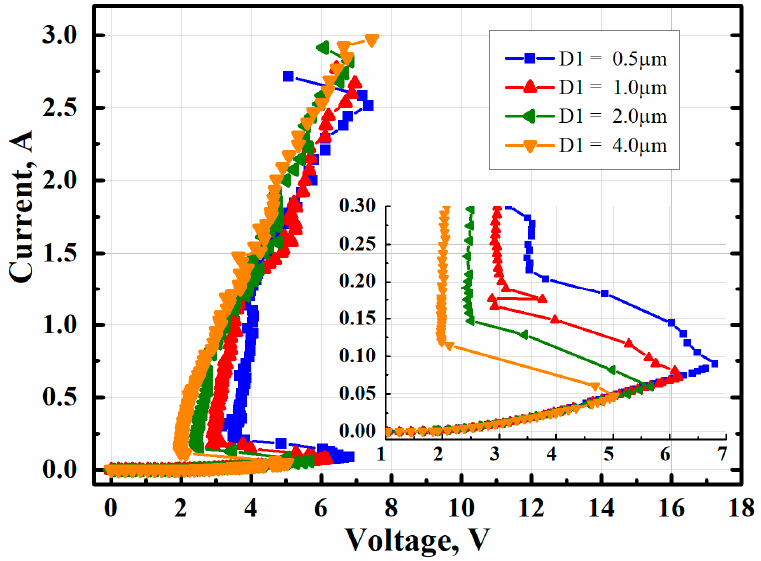
Figure 7. TLP test results of MTSCRs with four different D1. For 2.5 V circuits ESD protections, the holding voltage of the MTSCR can be further